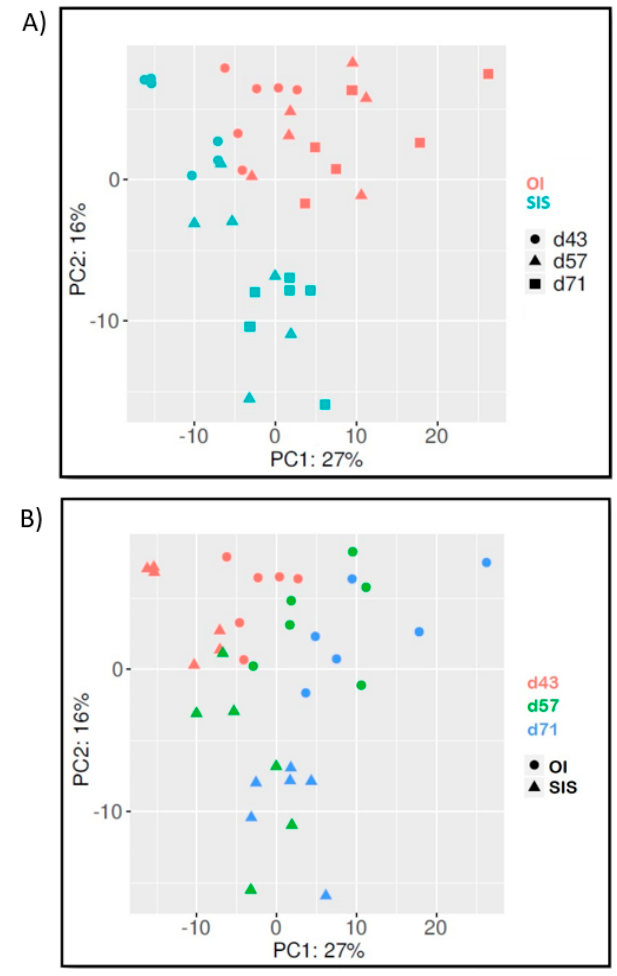
Figure 2. Comparison of intestinal bacterial communities from whiteleg shrimp using principle coordinate analysis (PCoA). The x and y axes correspond to principal components 1 (PC1) and 2 (PC2), which explained the highest level of variation. Both panels show the same ordination graph, highlighting differences in profile either between genetic lines ( A ) or tenure in production tank ( B ).